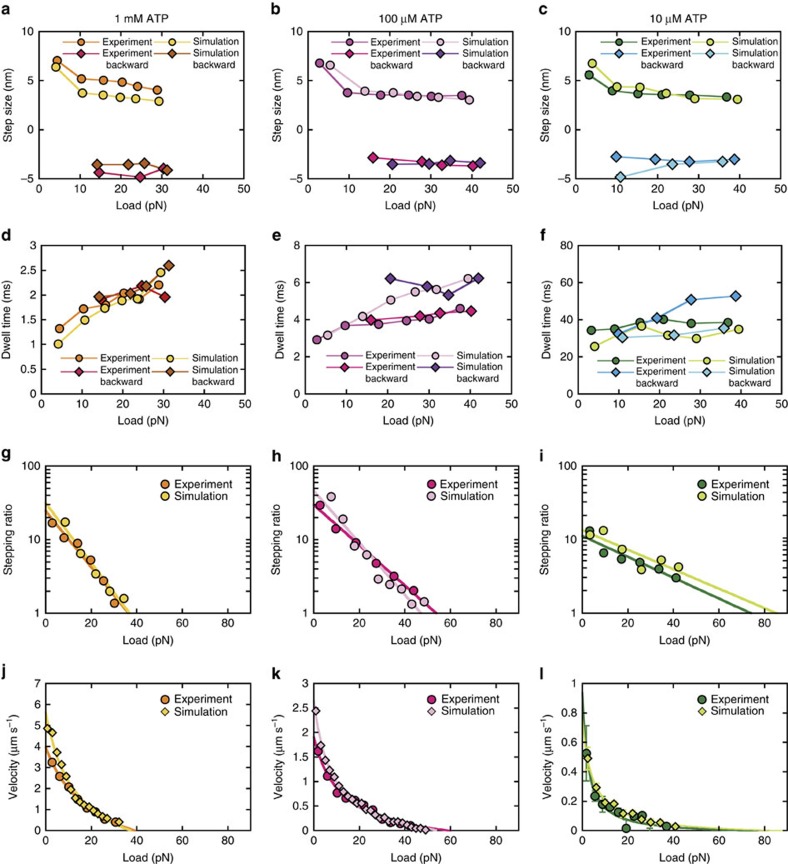
Step properties as a function of load at different ATP concentrations.(a–c) Mean forward and backward step sizes as a function of load obtained from experiments and the simulation model at 1 mM (experiment: n=181 and 84 for forward and backward steps, respectively, from 3 beads; simulation: n=649 and 220 for forward and backward steps, respectively, from 12 trials) in a, 100 μM in (n=863 and 205 for forward and backward steps, respectively, from 3 beads; simulation: n=668 and 239 for forward and backward steps, respectively, from 8 trials) in b and 10 μM ATP (n=335 and 89 for forward and backward steps, respectively, from 4 beads; simulation: n=368 and 114 for forward and backward steps, respectively, from 24 trials) in c. (d–f) Mean dwell times obtained from experiments and the simulation model at 1 mM, 100 μM and 10 μM ATP in d–f, respectively. The abscissas of the fitting functions provided estimates of the stall forces: 36, 54 and 74 pN at 1 mM, 100 μM and 10 μM ATP, respectively, in experiment; 37, 47 and 85 pN at 1 mM, 100 μM and 10 μM ATP, respectively, in simulation. (g–i) Stepping ratio calculated from experiments and the simulation model at 1 mM, 100 μM and 10 μM ATP in g-i, respectively. The natural logarithms of the stepping ratio were plotted against the load and fitted to linear functions; the abscissa represents the stall force. (j–l) Force–velocity (FV) relationships obtained from experiments and the simulation model at 1 mM (experiment: 7 beads; simulation 12 trials), 100 μM (experiment: 10 beads; simulation 8 trials) and 10 μM ATP (experiment: 6 beads; simulation 24 trials) in j–l, respectively. Each data set was fitted with Hill’s FV equation, (F+a)(V+b)=(F0+a)b, where F0, a and b are stall force and fitting parameters, respectively. The abscissas of the fitting functions provided estimates of the stall forces: 39, 59 and 73 pN at 1 mM, 100 μM and 10 μM ATP, respectively, in experiment; 37, 56 and 86 pN, respectively, in simulation. Error bars represent s.e.m., but most of them are hidden behind symbols.